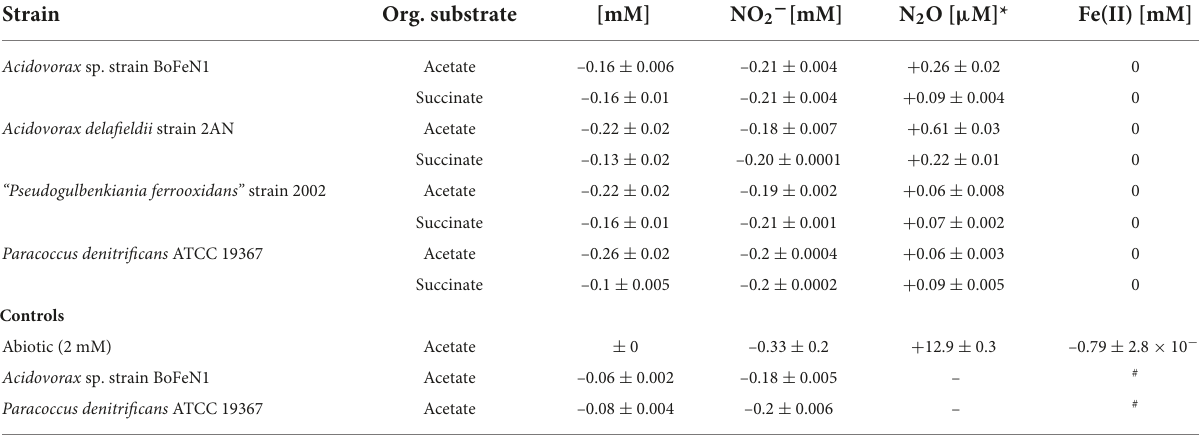
TABLE 3 Nitrite-based experiments: Concentration changes during heterotrophic growth for all four strains, as well as abiotic and biotic controls (BoFeN1 and the denitrifier 19367 grown under mixotrophic conditions with acetate only); – for reduction, + for production. Strain